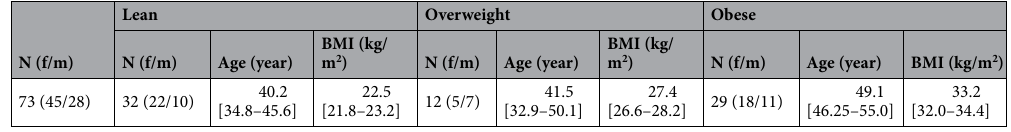
Table 1. Clinical characteristics of the Argentinean population. N population size, f female, m male. Age and BMI expressed as mean and 95% CI.